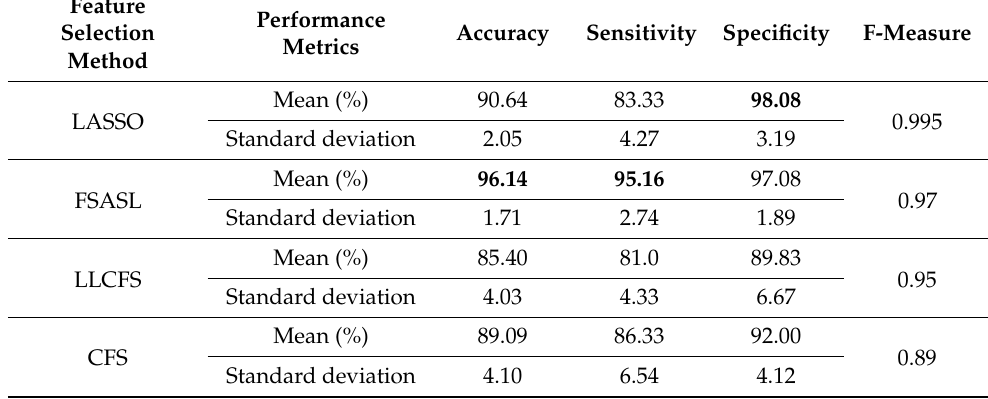
Table 3. Classification performance for HC against MCI using SL-RELM classifier on whole brain network using different feature selection methods.